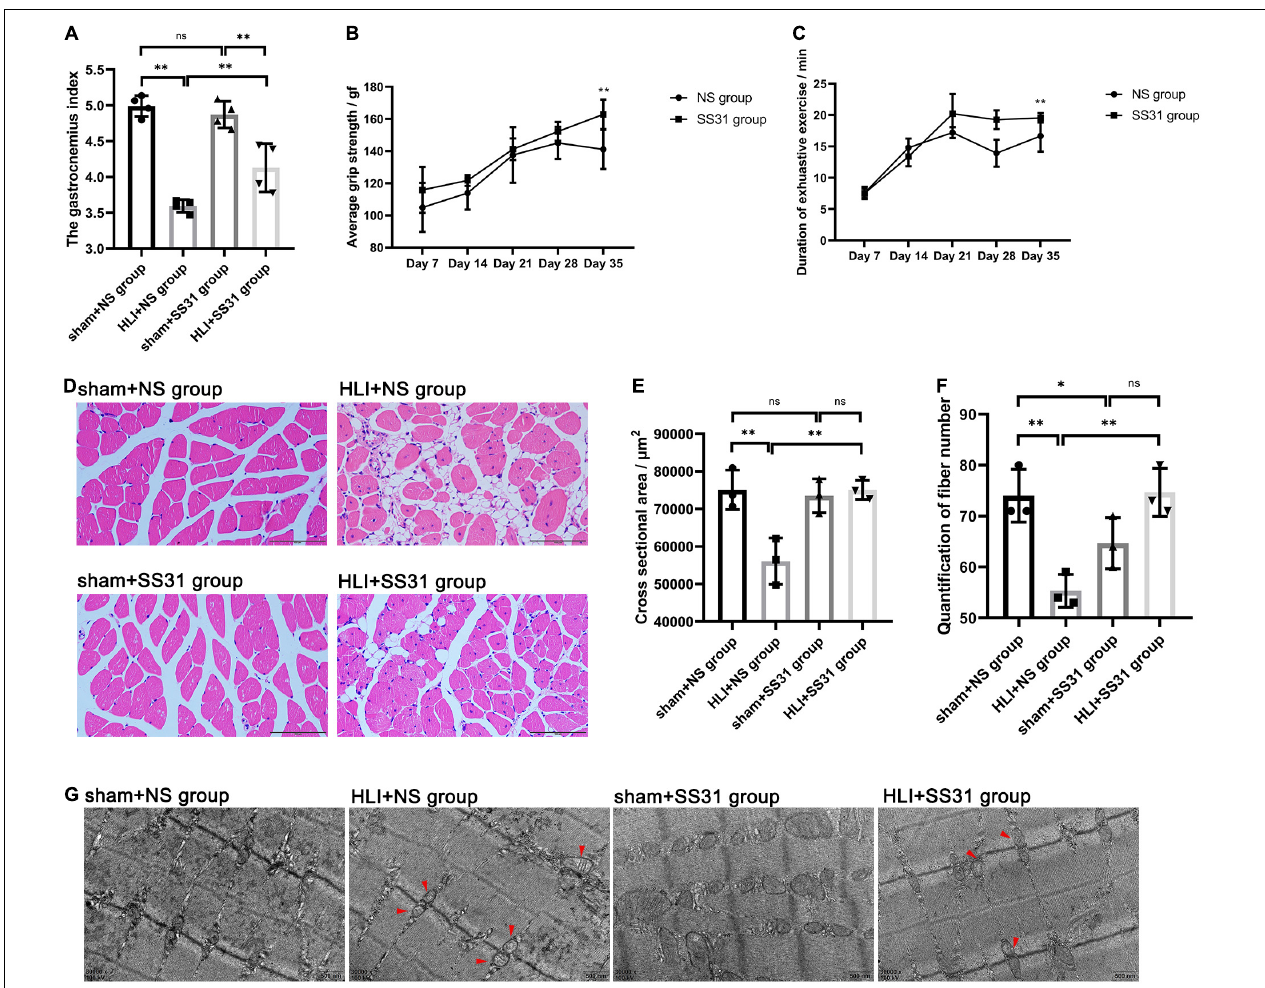
FIGURE 1 | SS31 improves skeletal muscle function in HLI mouse model. (A) Gastrocnemius index. (B) Grip strength test. (C) Duration of exhaustive exercise in minutes. (D–F) Skeletal muscle of the four groups was stained with HE (magnification of × 400). ImageJ was used to measure the fiber number and cross-sectional area of the gastrocnemius fibers. (G) TEM indicated that mitochondria were swollen and the Z-lines disorganized in HLI mice; however, SS31 treatment partially reversed these changes (red arrowheads indicate damaged mitochondria) (magnification of × 30,000). n = 3–6. ∗ p < 0.05, ∗∗ p < 0.01.